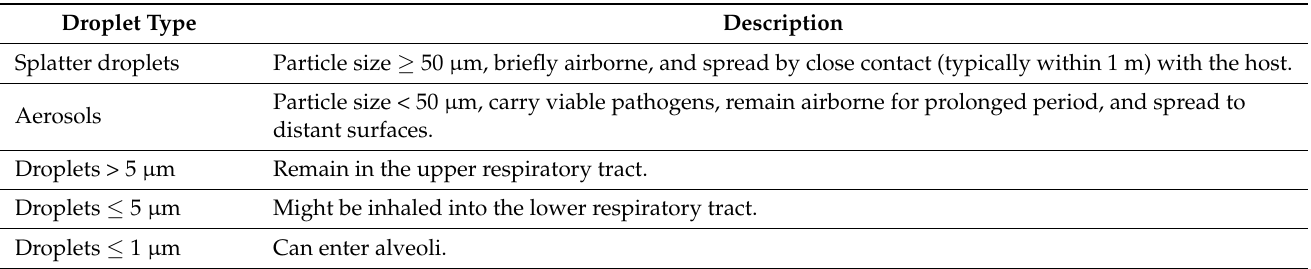
Table 9. Showing different types of aerosols and droplets and their significance [141] .